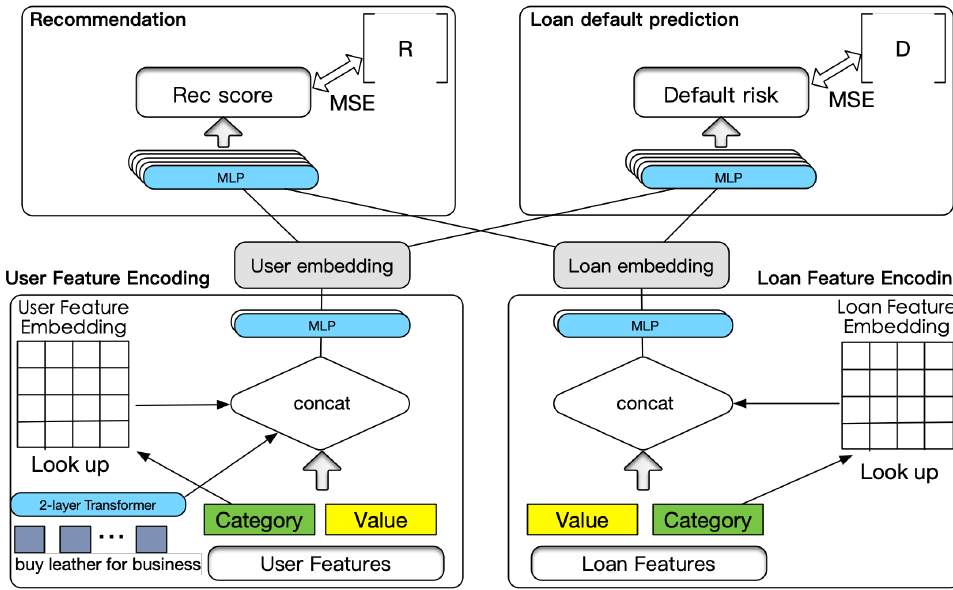
Figure 1. The architecture of